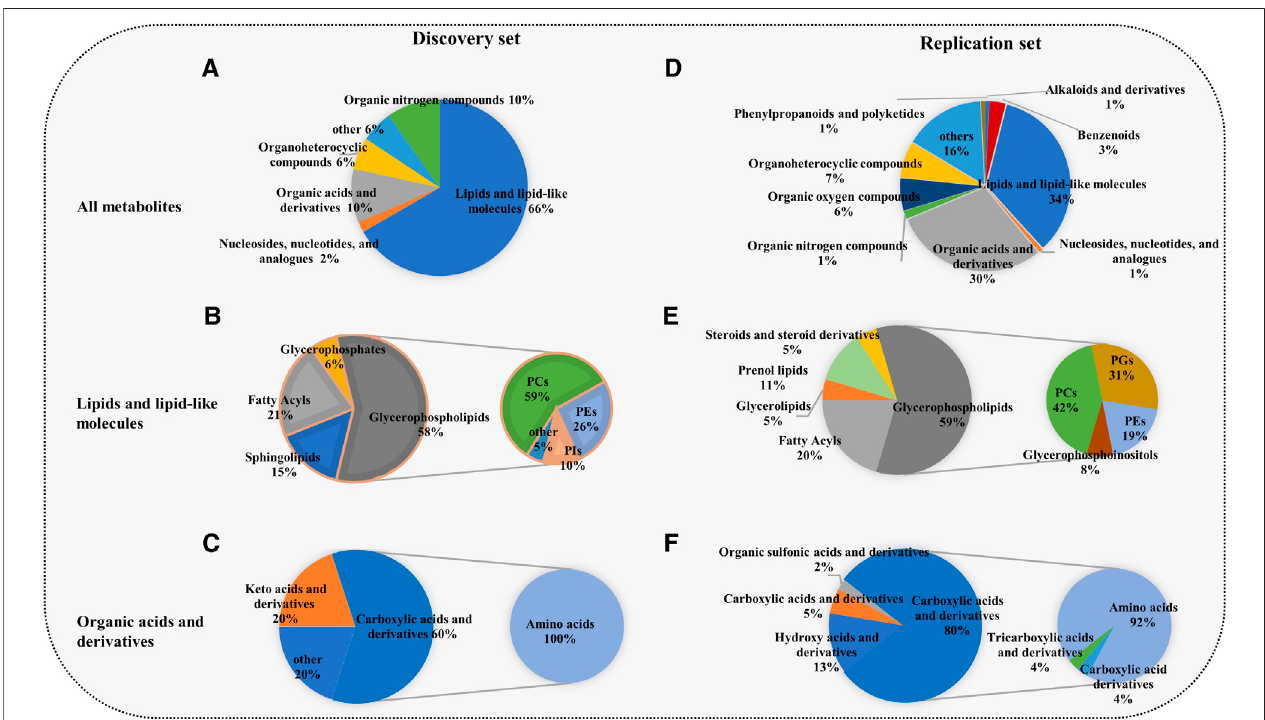
FIGURE 2 | Composition of the differential metabolites in the discovery set and replication set. (A,D) The superclasses of all metabolites. (B,E) Lipids and lipid-like molecules and organic acids and their derivatives were the most common superclasses. (C,F) Glycerophospholipids and amino acids were the main classes. The primary pie shows the composition of lipids and lipid-like molecules and organic acids and derivatives, and the secondary pie displays the component category of glycerophospholipids and amino acids. The superclass, class and subclass of metabolites were acquired from the Human Metabolome Database. GPs, glycerophospholipids; PCs, glycerophosphocholines; PGs, glycerophosphoglycerols; PIs, glycerophosphoinositols; PEs, glycerophosphoethanolamines; amino acids: amino acids, peptides and